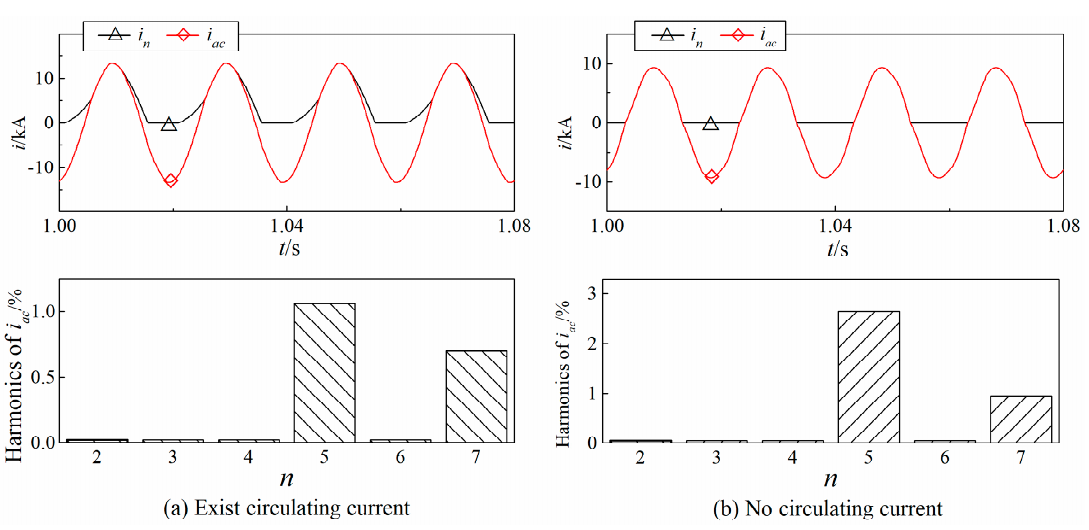
Figure 8. Relationship between the AC current and arm current. ( a ) Exist circulating current; ( b ) No circulating current.